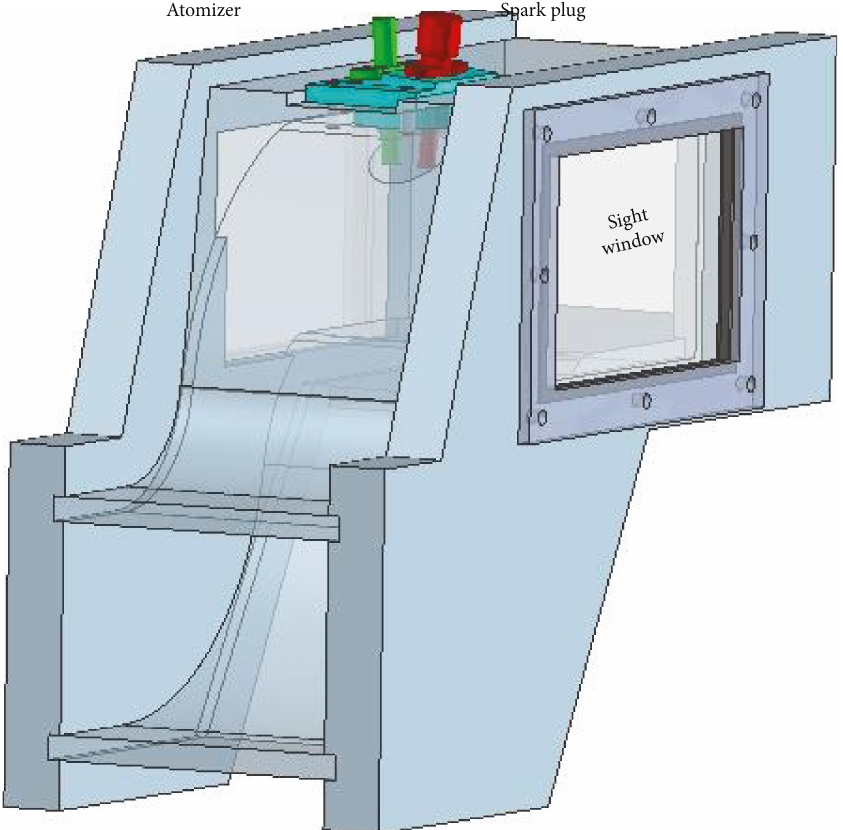
Figure 2: Rectangular structure combustor.